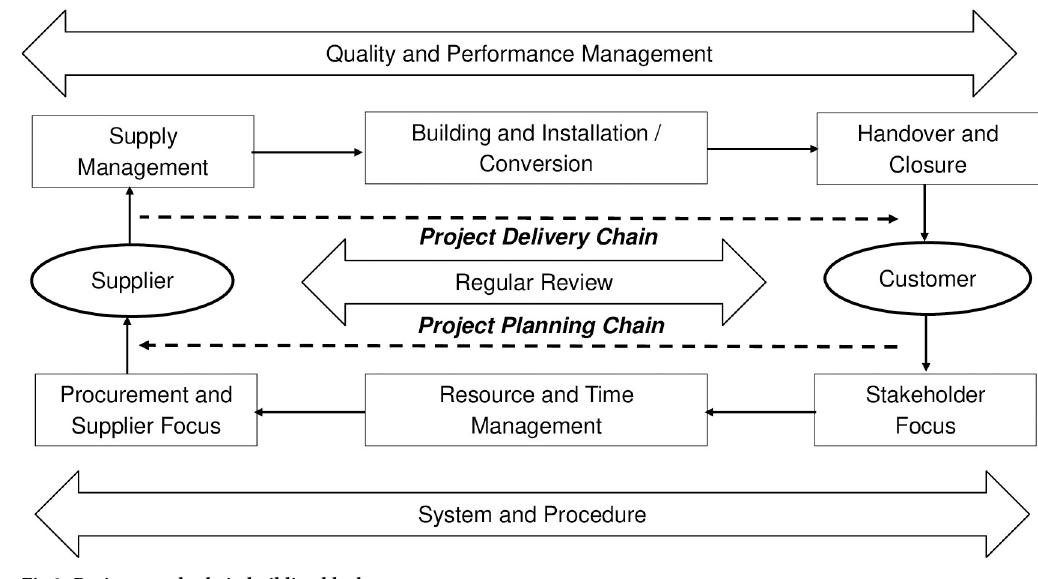
Fig 2. Project supply chain building